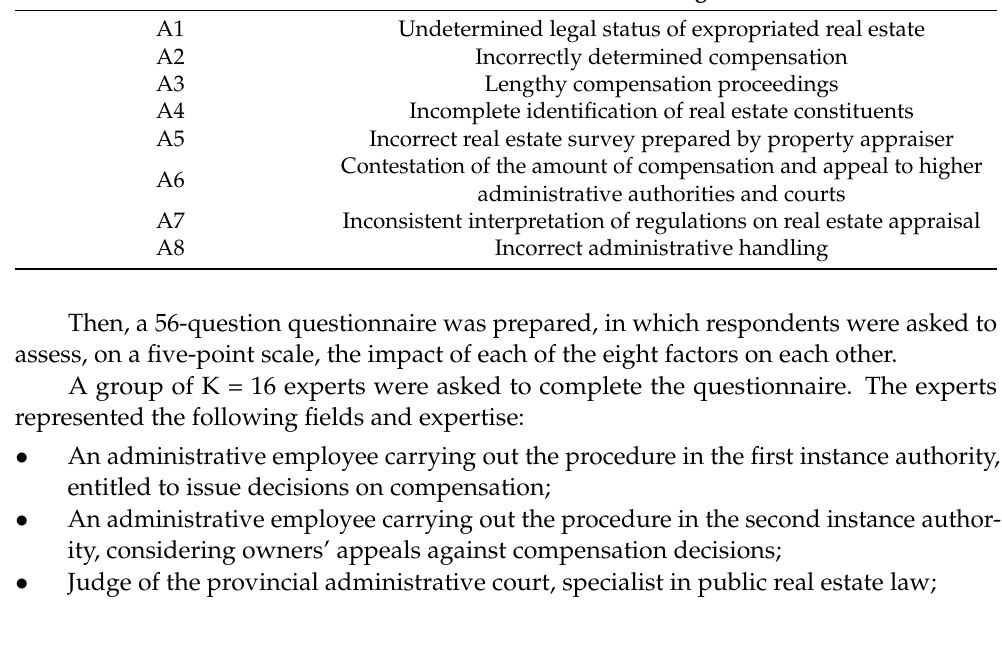
Table 2. The meaning of factors and their denotations. Factor